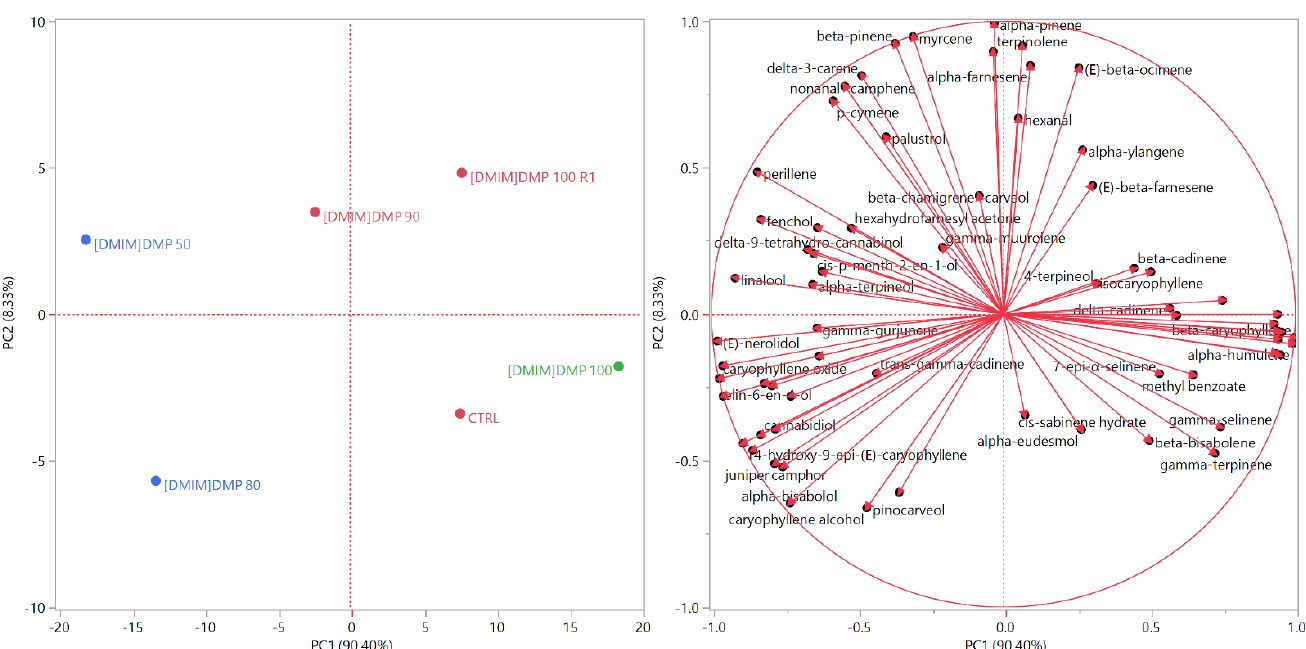
Figure 2. Score ( a ) and loading ( b ) plots of the principal component analysis (PCA) performed on the complete EO compositions of all samples.